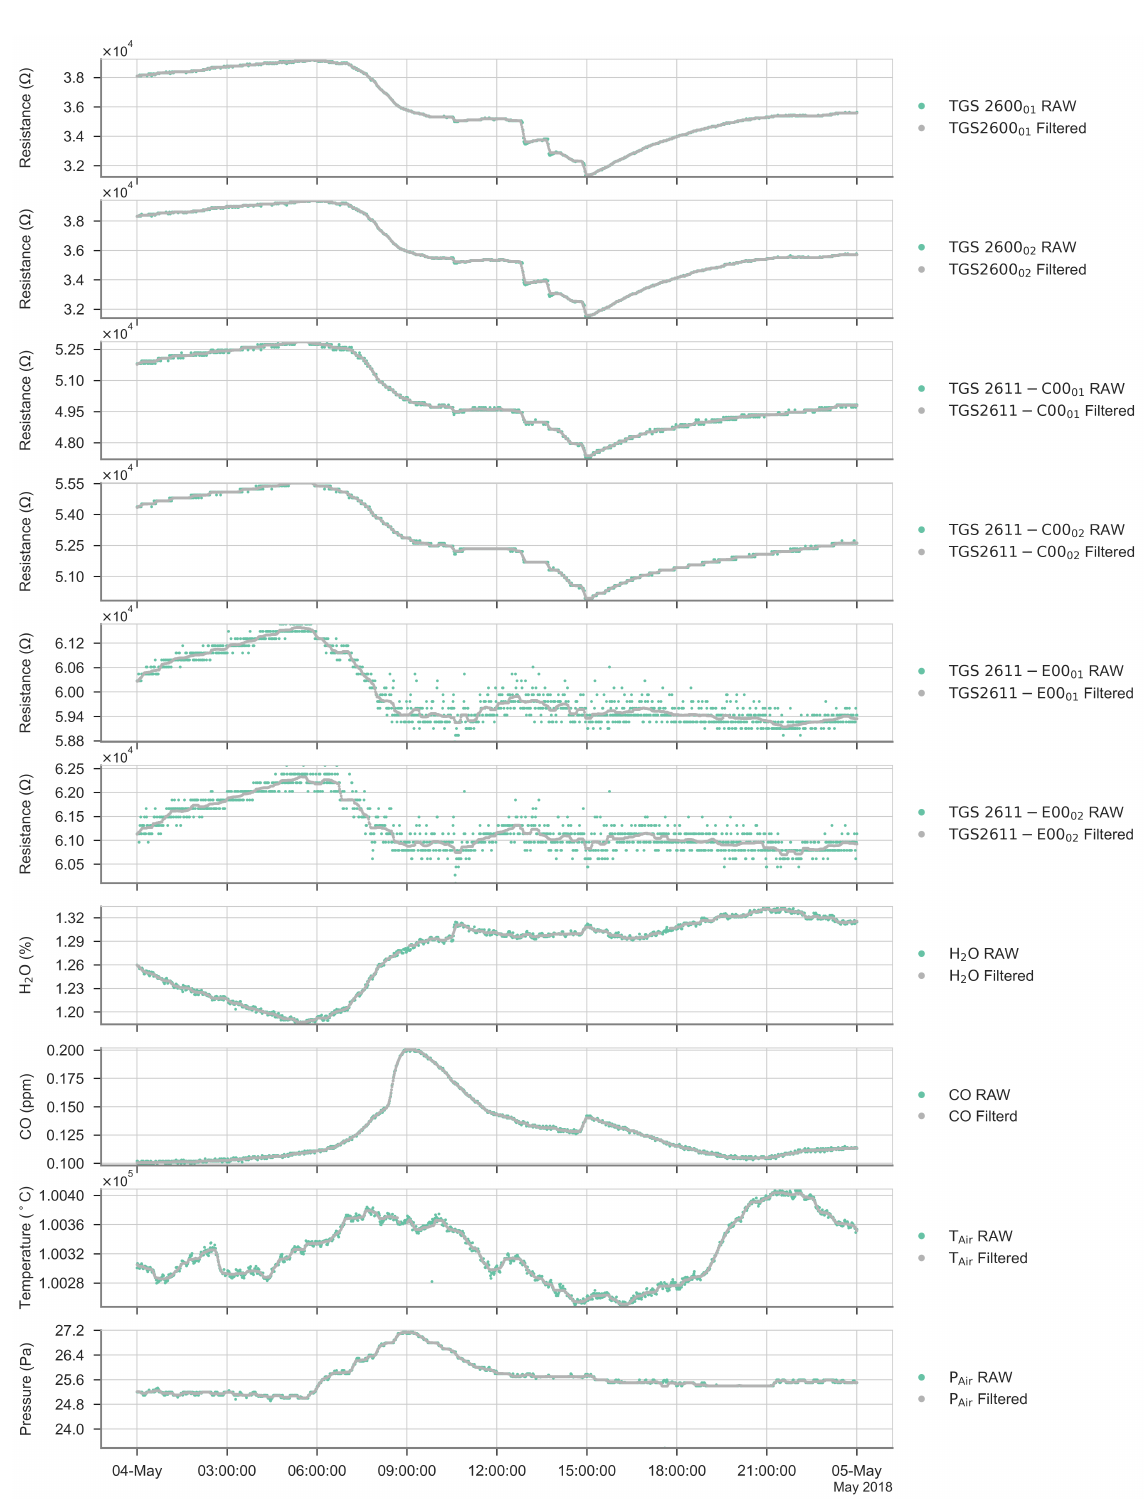
Figure A1. Comparison between the raw (green) and the filtered signal (gray) over one